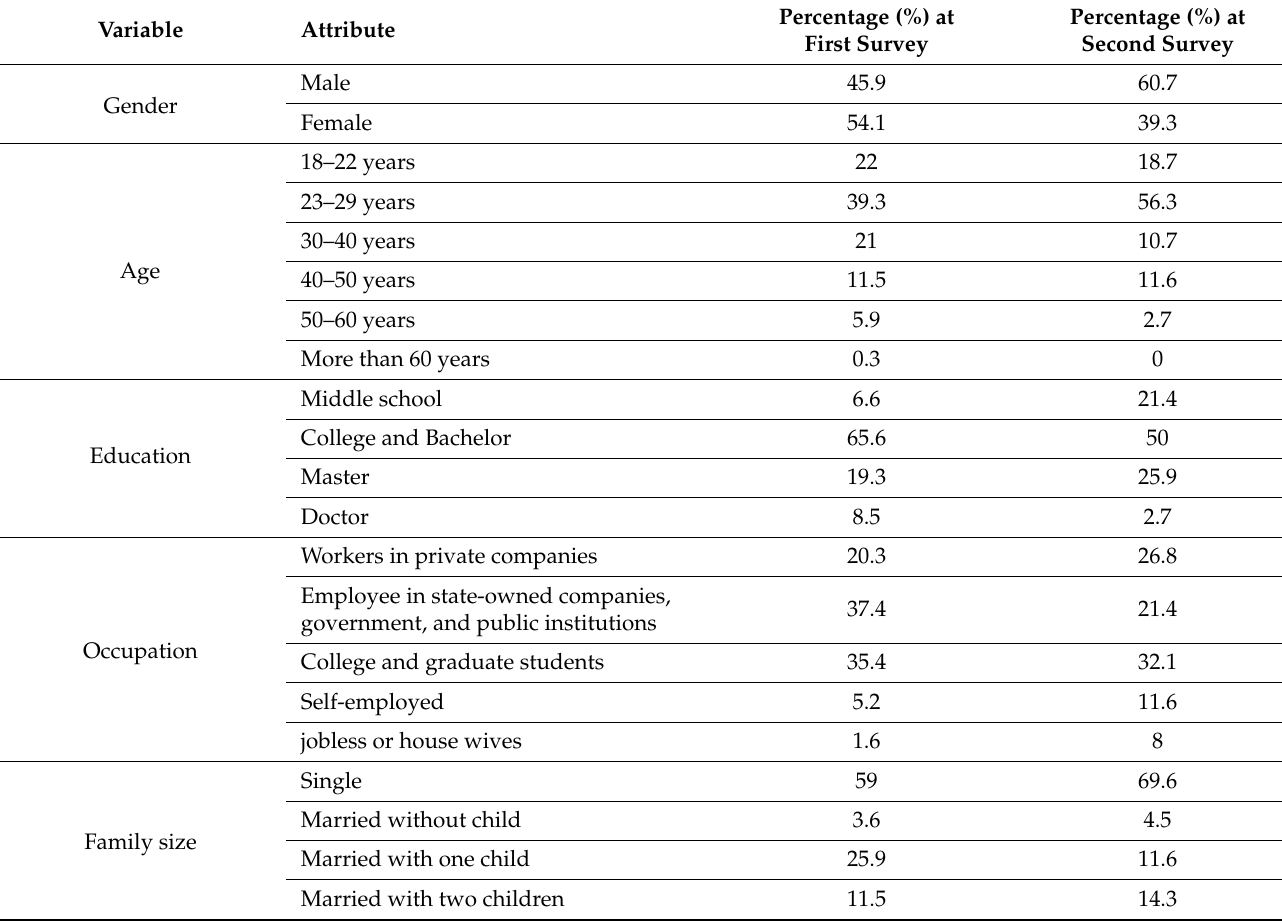
Table 1. Basic social demographic information of